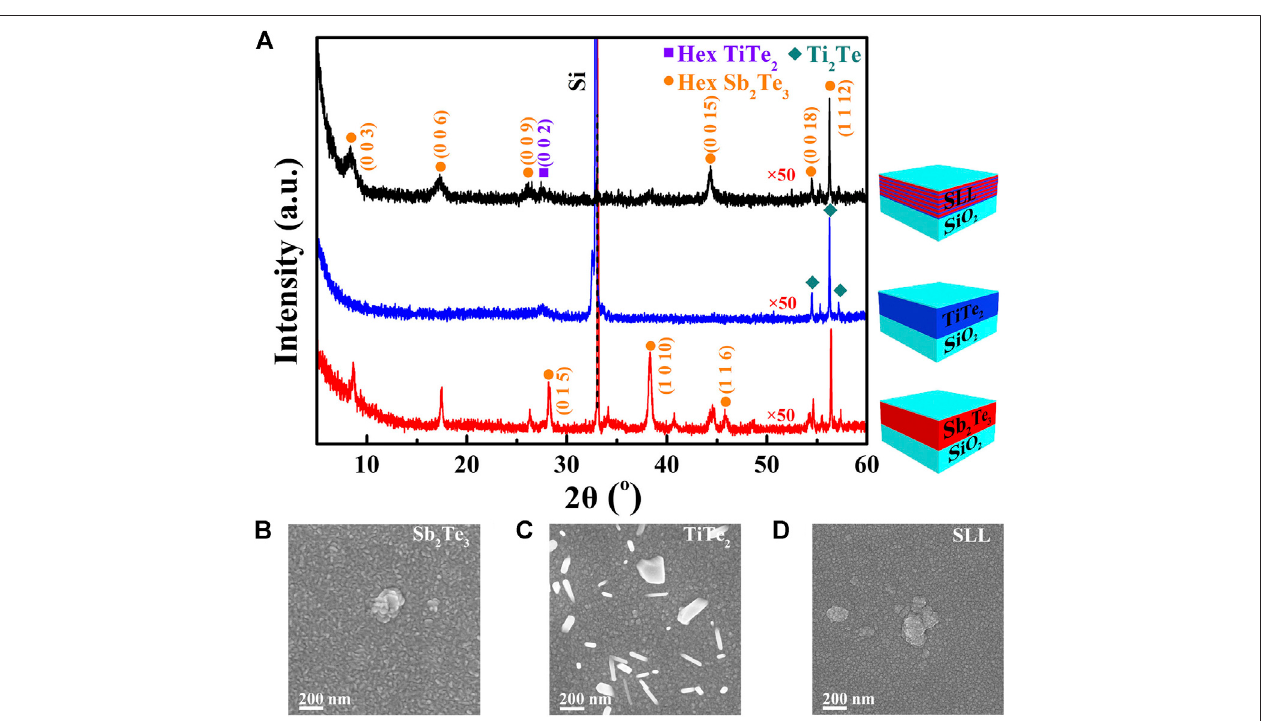
FIGURE 1 | (A) XRD curves of ∼ 100 nm thick Sb 2 Te 3 , TiTe 2 , and SLL fi lms sandwiched between SiO 2 layers (see the corresponding sketch). The fi lms were all deposited at room temperature and then postannealed at 300 ° C for 1 h, mainly showing the hexagonal (Hex) lattice con fi guration. For the sake of better observing the weak diffraction peaks, the diffraction intensity is multiplied by 50 for all the curves. (B – D) SEM images of the postannealed Sb 2 Te 3 , TiTe 2 , and SLL fi lms, respectively.